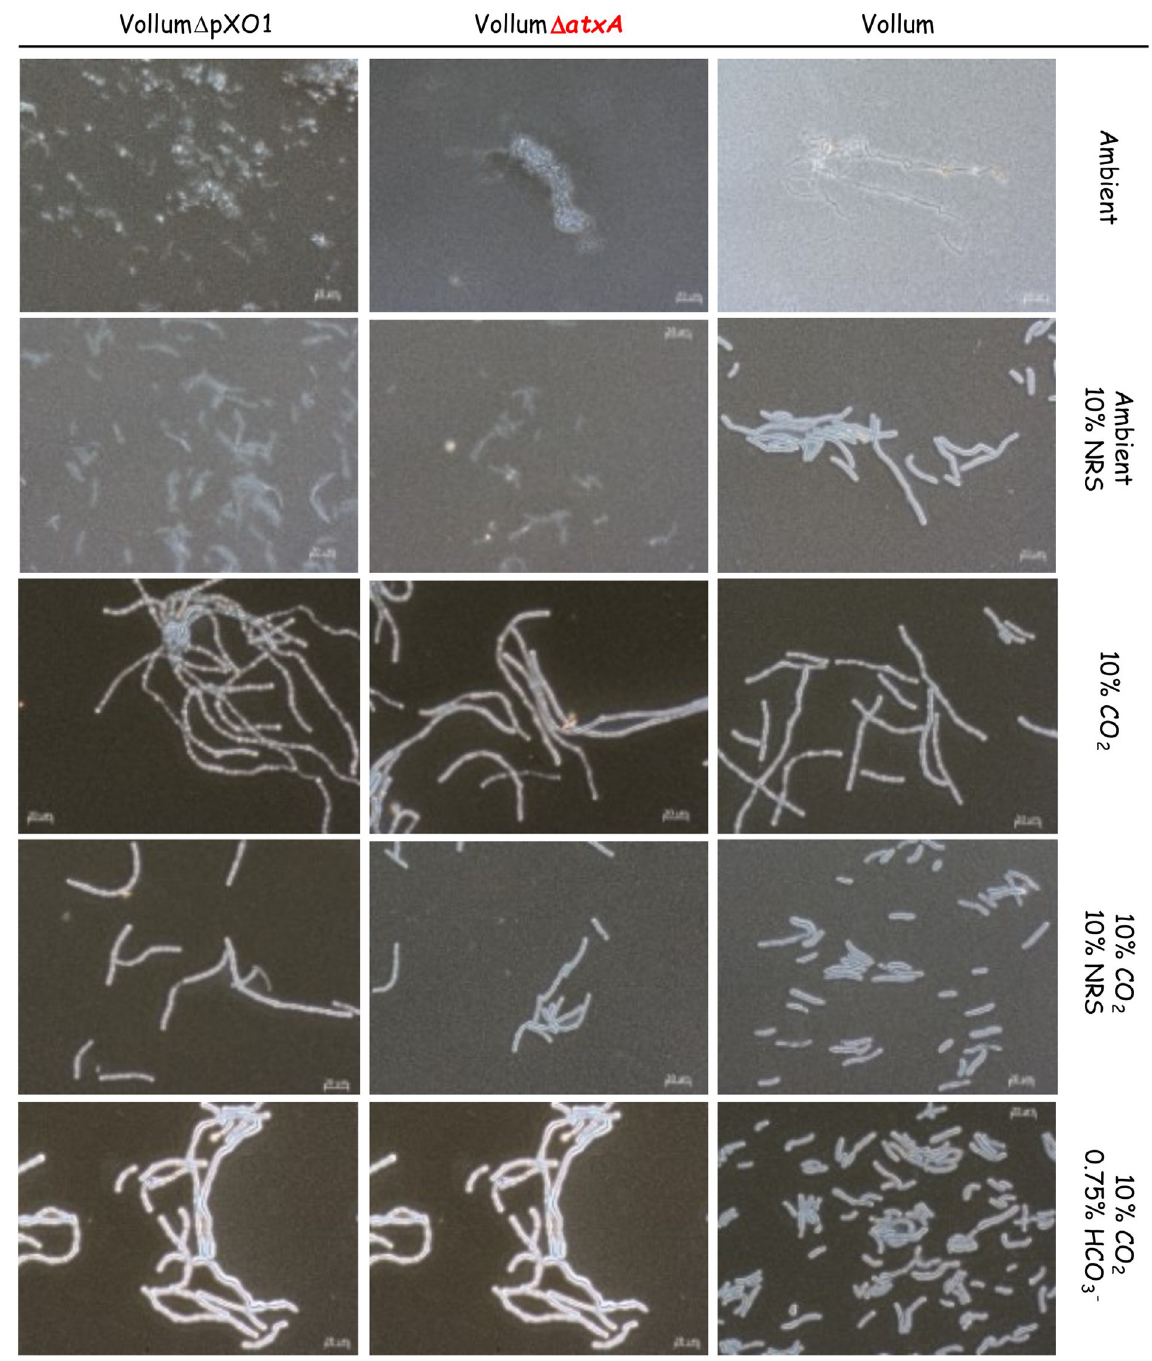
Fig 2. Capsule production of the Vollum wild type, Δ pXO1 or Δ atXA mutants under different growth conditions. Spores of the wild type and different mutants (top panel) were seeded into 100 μ l of sDMEM. The same strains were grown in sDMEM supplemented with 10% NRS (second row). The same conditions or supplemented with 0.75% HCO 3- were applied in the presence of 10% CO 2 (lower three rows) for 24h. Capsule was imaged by India ink negative staining (capsule presence forms a typical bright outer layer).